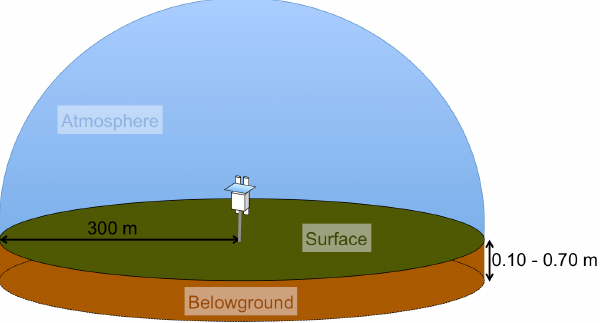
Figure 1. Schematic representation of the effective measurement volume for the cosmic-ray soil moisture sensor. The effective depth depicted in the figure refers to the overall range in the sensor (Zreda et al., 2008). Notice that the effective depth estimated for the syn- thetic experiments in this study varies approximately between 12 and 20cm (refer to